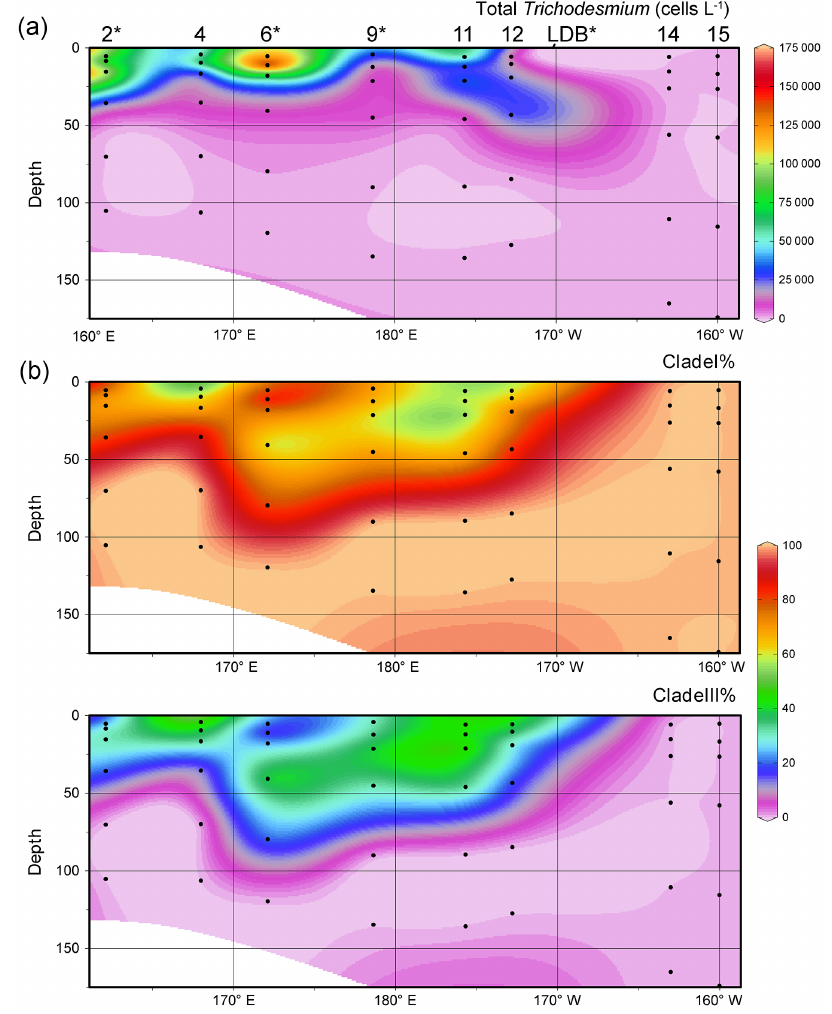
Figure 2. Abundance and clade distribution of Trichodesmium . Black dots denote the depths at which samples were taken, while station numbers are indicated above the panels. (a) Concentration of total Trichodesmium cells estimated from qPCR of the rnpB gene (cellsL − 1 ). (b) Relative proportion of Trichodesmium Clade I and Clade III across the transect. Clade I includes T. thiebautii , T. tenue , T. hildebrandtii , and T. spiralis . Clade III includes T. erythraeum and T. contortum . ∗ indicates stations where metatranscriptomic sequences were sampled. Clade samples were not obtained at LD